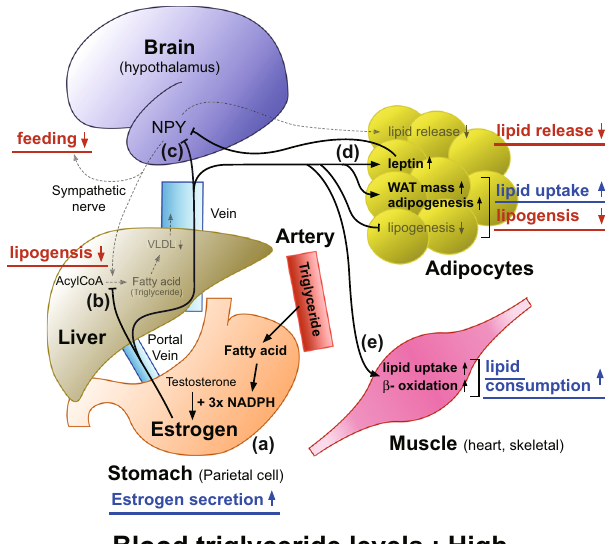
Fig. 6 Proposed model for the role of gastric estrogen in maintaining proper blood triglyceride levels. a Parietal cells in the stomach produce estrogen using fatty acid (triglyceride) as an energy source (NADPH), and secretion of gastric estrogen increases as blood triglyceride levels rise (this study). b Gastric estrogen, secreted into the portal vein, primarily acts on the liver to suppress hepatic de novo lipogenesis 15 . c Gastric estrogen inhibits hypothalamic NPY neurons, whose activation enhances feeding behavior, hepatic de novo lipogenesis, and fatty acid release from adipocytes via sympathetic nerves 19, 44 – 47 . d Gastric estrogen acts on adipocytes to suppress their de novo lipogenesis and to increase leptin secretion, white adipose tissue (WAT) mass, and adipogenesis 17 . Leptin, in turn, inhibits hypothalamic NPY neurons 5 . e Gastric estrogen increases the lipid uptake and β -oxidation of heart and skeletal muscles 20 . a – e When blood triglyceride levels are high, secretion of gastric estrogen increases. Increased estrogen inhibits feeding behavior, de novo lipogenesis, and lipid release from adipose tissues while promoting lipid uptake by WAT and lipid consumption by muscles. As a result, blood triglyceride levels are lowered. Conversely, when blood triglyceride levels are low, secretions of gastric estrogen are decreased to supply more lipid to the